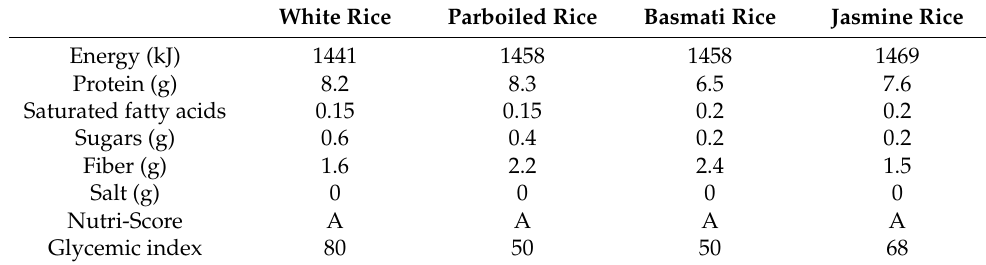
Table 4. Selected nutritional value of selected rice (per 100 g) and their Nutri-Score. White Rice Parboiled Rice Basmati Rice Jasmine Rice